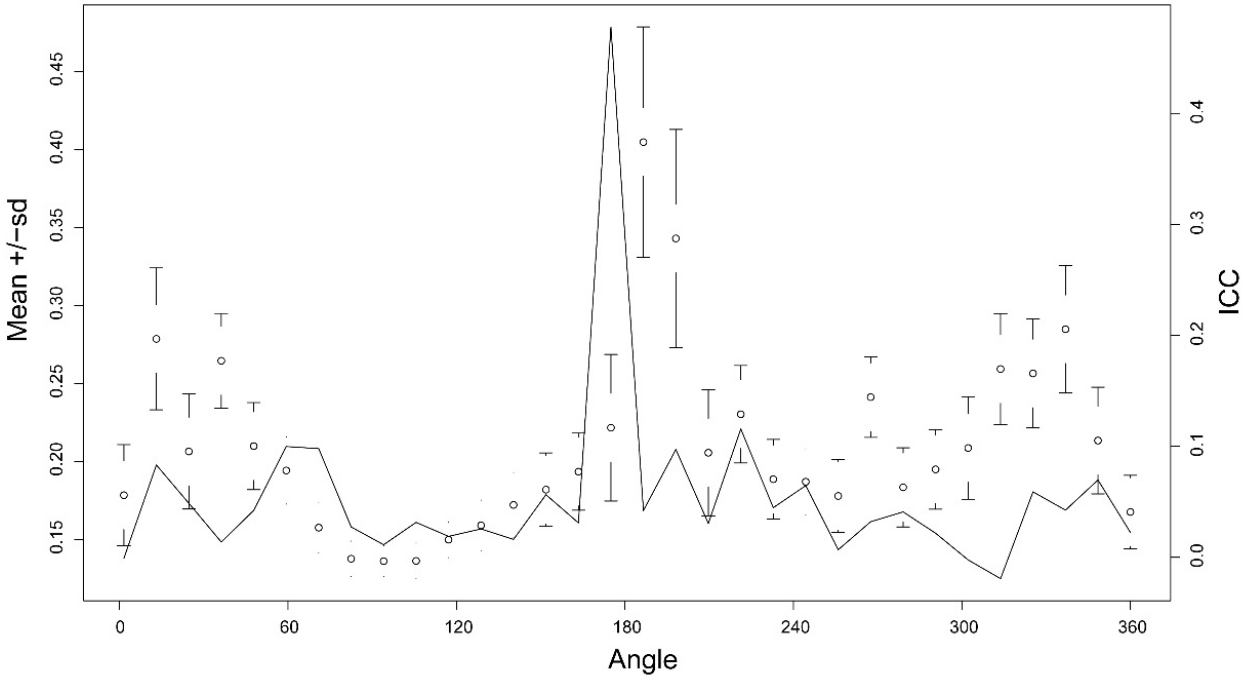
Figure 4. Mean and Standard deviation (SD) of the wavelet coefficients representing shape for all combined otoliths and the proportion of variance among silverside of different localities or interclass correlation (ICC, black solid line). The central axis shows the angle in degrees (°) based on polar coordinates where the centroid of the otolith is the central point of the polar coordinates.